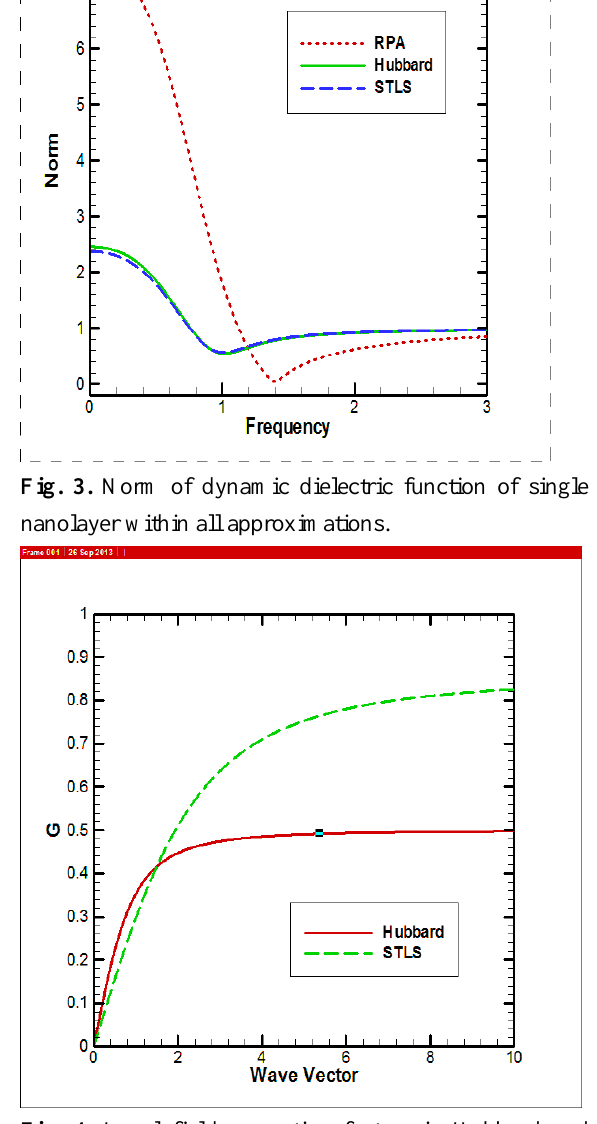
Fig. 4. Local field correction factors in Hubbard and STLS